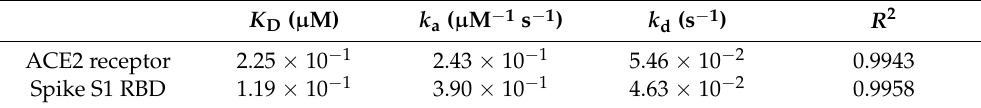
Figure 2. The global kinetic analysis of mulberrofuran G (MG) binding to biotinylated ( A ) ACE2 receptor and ( B ) spike S1 RBD immobilized on a streptavidin-coated sensor. The kinetics of MG for the spike S1 or ACE2 receptor were measured from the association of 0, 50, 100, 200, and 400 nM of MG in PBS containing 1% DMSO with immobilized spike S1 or ACE2 receptor and the subsequent dissociation in PBS containing 1% DMSO. The degree of MG binding was represented as a shift in wavelength (nm) between the bound and reference signals in the biosensor. Table 1. The binding kinetics of mulberrofuran G to spike S1 RBD and ACE2 receptor.